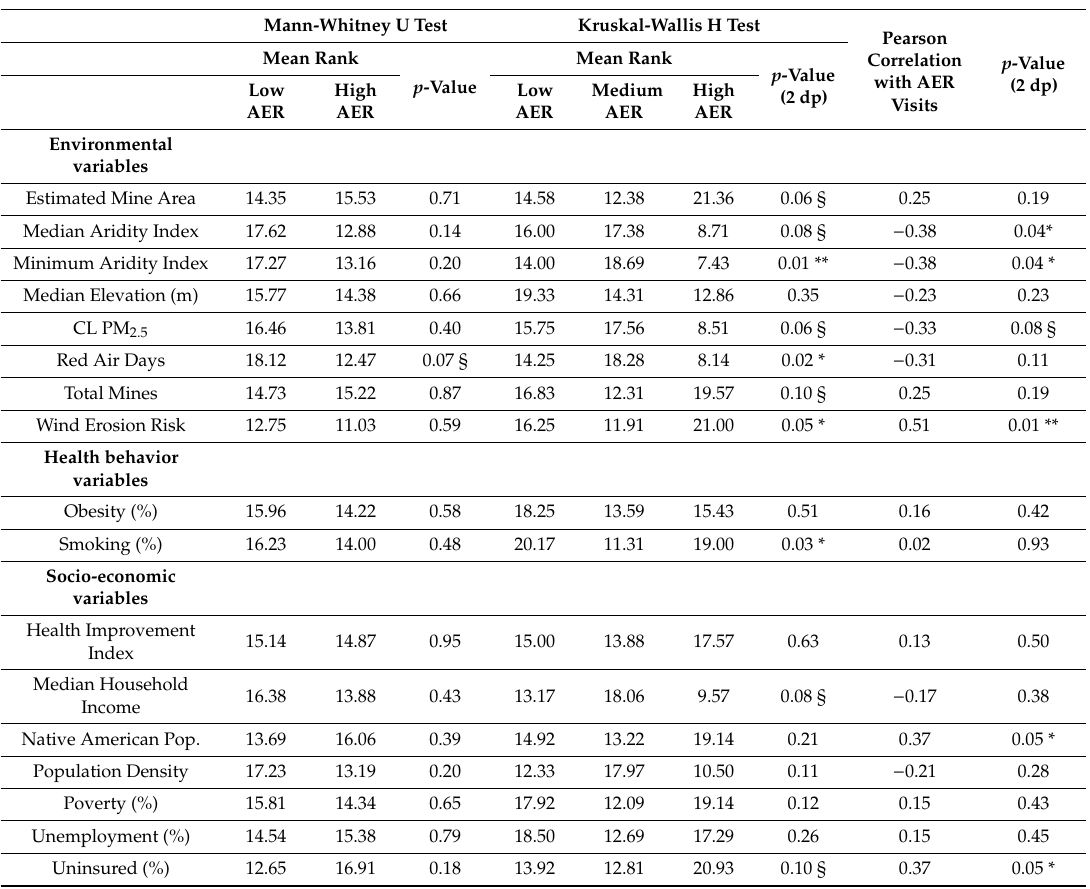
Table 5. Mean ranks of risk factor variables for low and high AER groups (Mann-Whitney U test) and low, medium and high AER groups (Kruskal-Wallis H test) and Pearson correlation of risk factors with AER